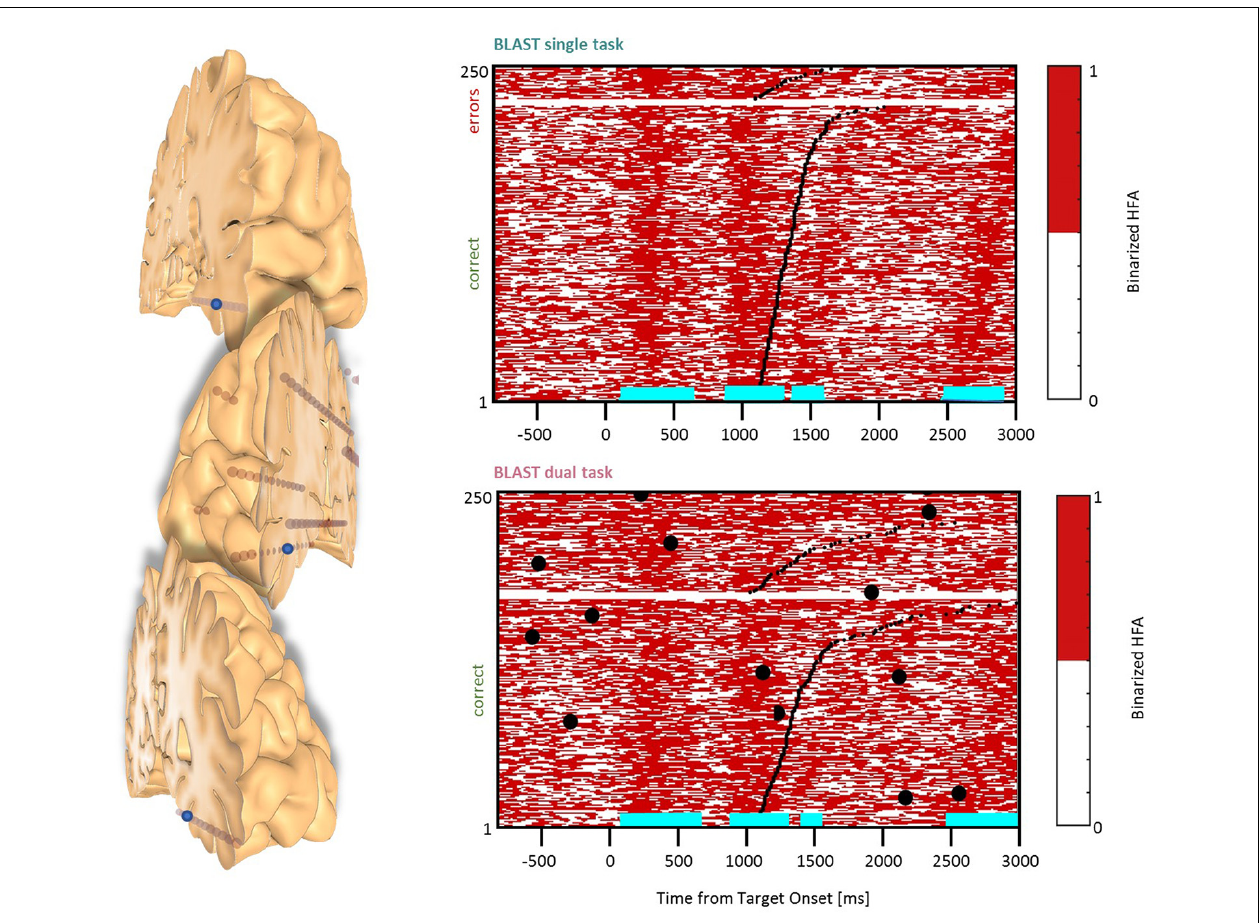
FIGURE 9 | Interference in the Basal Temporal Cortex. Sites with interference between T1 and T2 are displayed at their precise anatomical location onto a 3D representation of the participant’s brain. The matrix representation reproduces the display of Figure 2 , for the single-task and dual-task conditions for one of the sites. Patients id [Px] and iEEG site names, from left to right and top to bottom: E’7 [P4]; F6 [P1] (matrix displayed); L’3